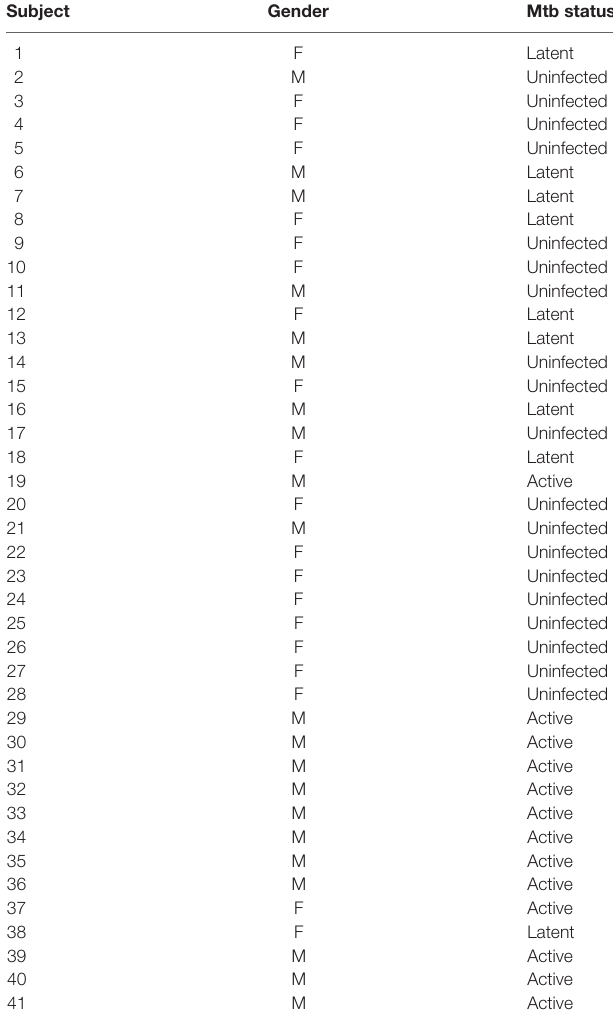
Table 1 | Demographics and Mycobacterium tuberculosis (Mtb) status of HIV- 1-uninfected subjects. gender Mtb